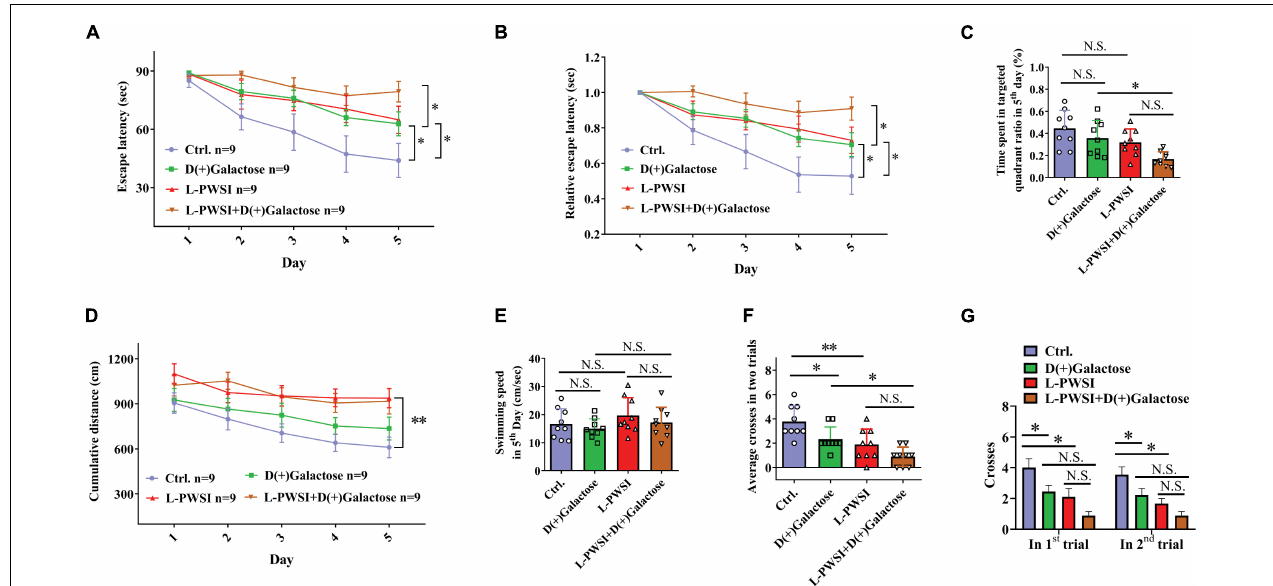
FIGURE 2 | Spatial learning behavior is worsened in the long-term post-weaned social isolation (L-PWSI) and D(+)Galactose-treated mice in the Morris water maze (MWM). (A,B) The escape latencies and relative escape latencies were calculated for the various treatment and control groups of mice. The escape latencies of the four groups of mice on the first day were normalized to 1.0. The relative escape latencies on the subsequent days were calculated relative to those on the first day. (C) The total time spent in the targeted quadrant on the fifth day of the trial. (D) The cumulative distance (to the platform) during the training session (acquisition session). (E) The swimming speed of mice on the fifth day of the trial. (F) The average number of times that the four groups of mice swam across the target sites after retrieval of the platform (two trails). (G) The number of crossing the target sites in each trail after retrieval of the platform. Data are presented as the mean ± SEM. from 9 mice in each group. ∗ represents p < 0.05; ∗∗ represents p < 0.01; N.S., represents no significance.